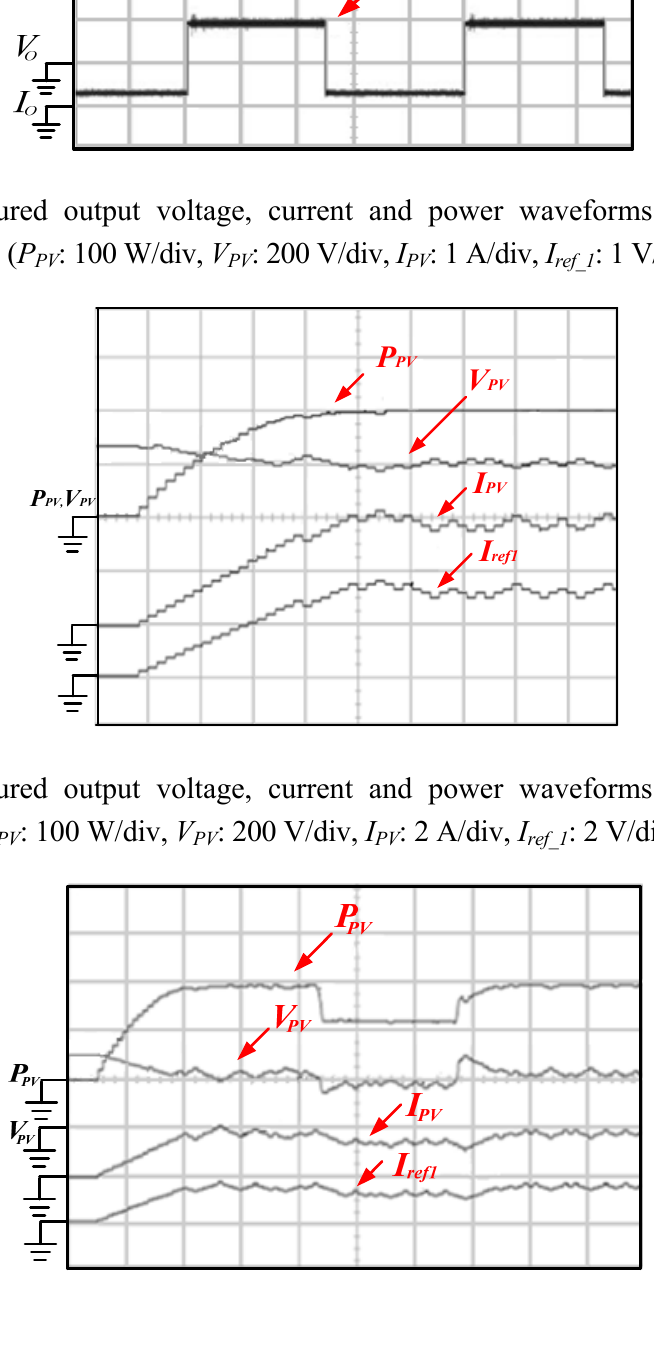
Figure 18. Measured step-load changes between 20% and 100% of the full load. : 10 V/div; I : 5 A/div; time : 500 ms/div). ( V o o